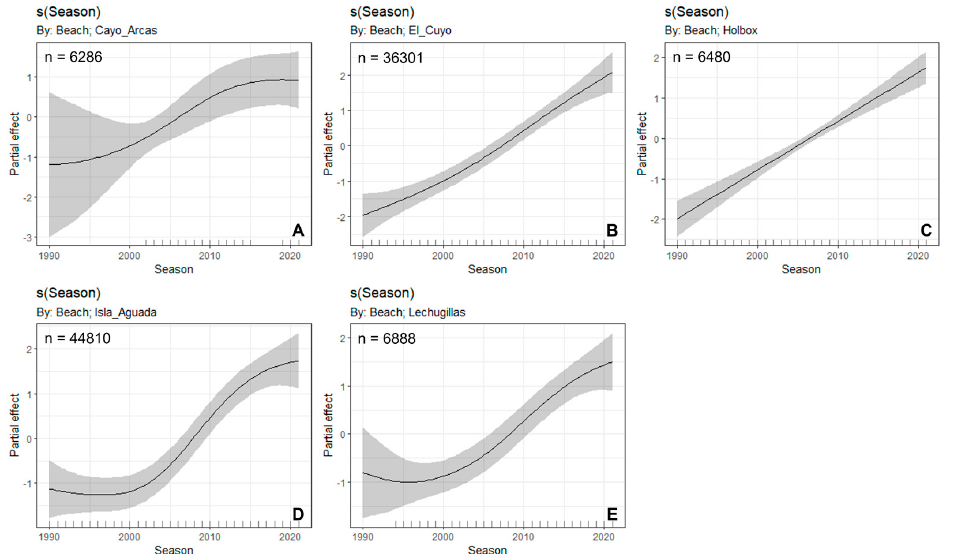
Figure 3. Trends in nest abundance of green turtles ( Chelonia mydas ) at Cayos Arcas ( A ), El Cuyo ( B ), Holbox ( C ), Isla Aguada ( D ), and Lechuguillas ( E ). The black line is the smooth spline line, and the grey areas are the 95% Bayesian confidence intervals. San Lorenzo and Celestún were excluded from the analysis due to their small sample size. Table 3. Results of the Generalized Additive Models to evaluate the temporal effects of the nesting season on the number of nests of green ( Chelonia mydas ) sea turtles at five nesting beaches in the Gulf of Mexico. San Lorenzo and Celestún were excluded from the analysis due to their small sam- ple size. N Nest as Function of s (Season, by = Beach) + Beach (Negative Binomial, Link = Log) Chelonia mydas Estimate